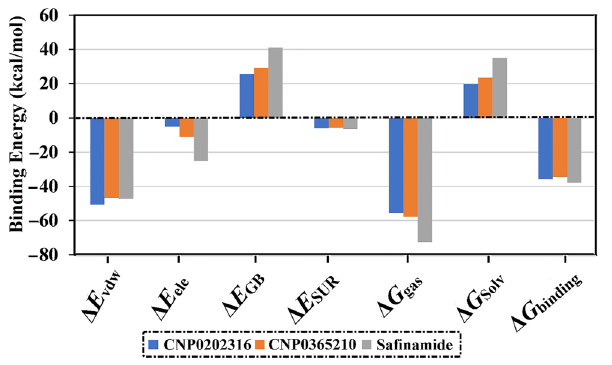
Figure 9: Binding poses of CNP0202316 (A), CNP0365210 (B), and istradefylline (C) (shown in olive green color) with AA superposed to the crystal structure of caffeine (shown in green color).